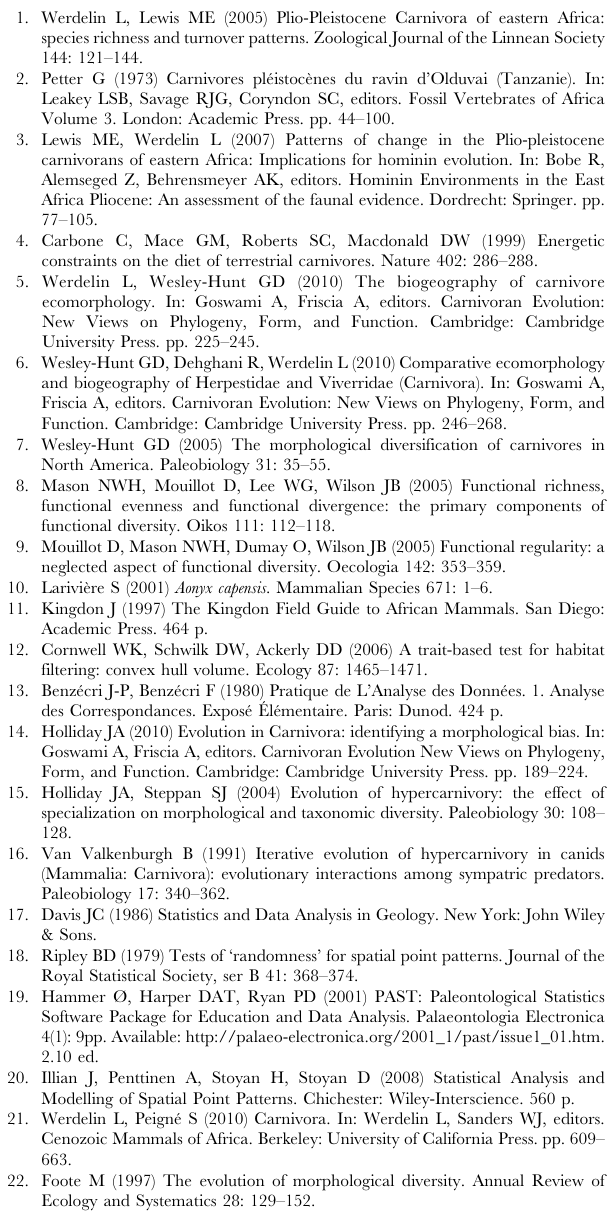
Table S2 Taxon coding of 216 extant carnivoran